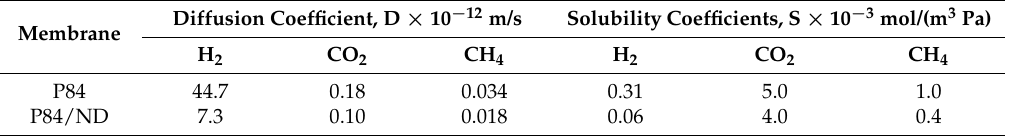
Table 4. Diffusion coefficients and solubility coefficients for H 2 , CO 2 , and CH 4